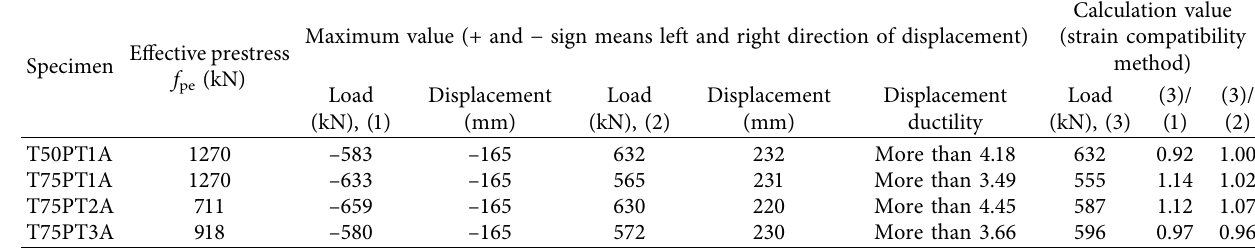
Table 5: Maximum loads and displacements of test